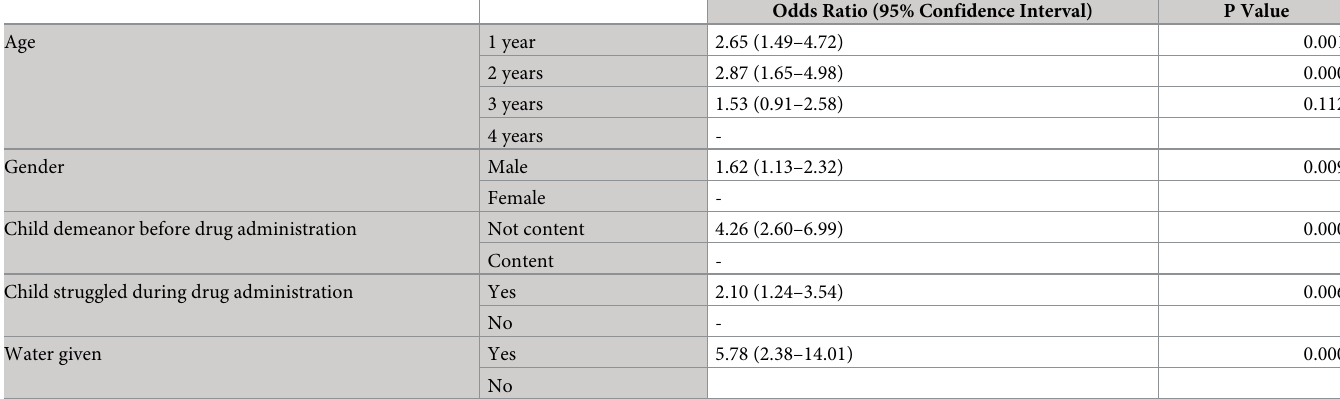
Table 4. Factors independently associated with adverse swallowing events during administration of preventive chemotherapy for soil-transmitted helminthiasis, multivariate logistic regression.